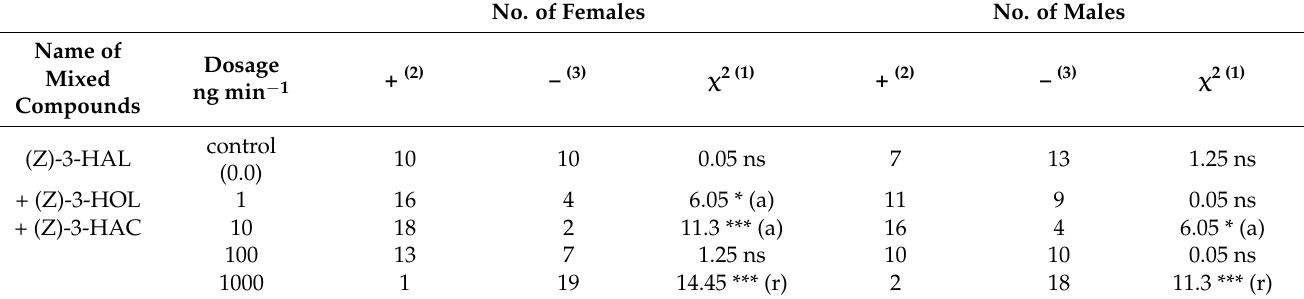
Legend for Tables 3 and 4: (1) level of significance (ns—not significant), (* p < 0.05), (** p < 0.01), (*** p < 0.001),